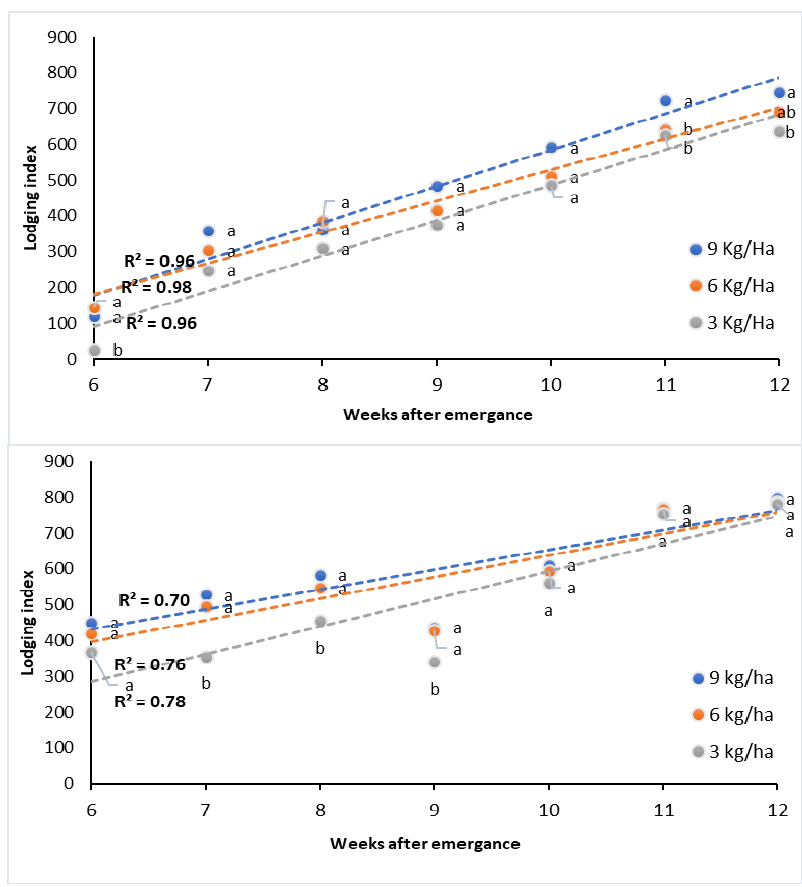
Figure 5. Lodging development (expressed as lodging index) between week 6 and 12 (season end) in 2018 (top) and 2019 (bottom). Data were averaged across genotypes for the three sowing rates: 9 kg/ha (blue), 6 kg/ha (red), and 3 kg/ha (grey). Linear fits and their R 2 values are presented. Different letters at a given time point indicate significant differences at P < 0.05.